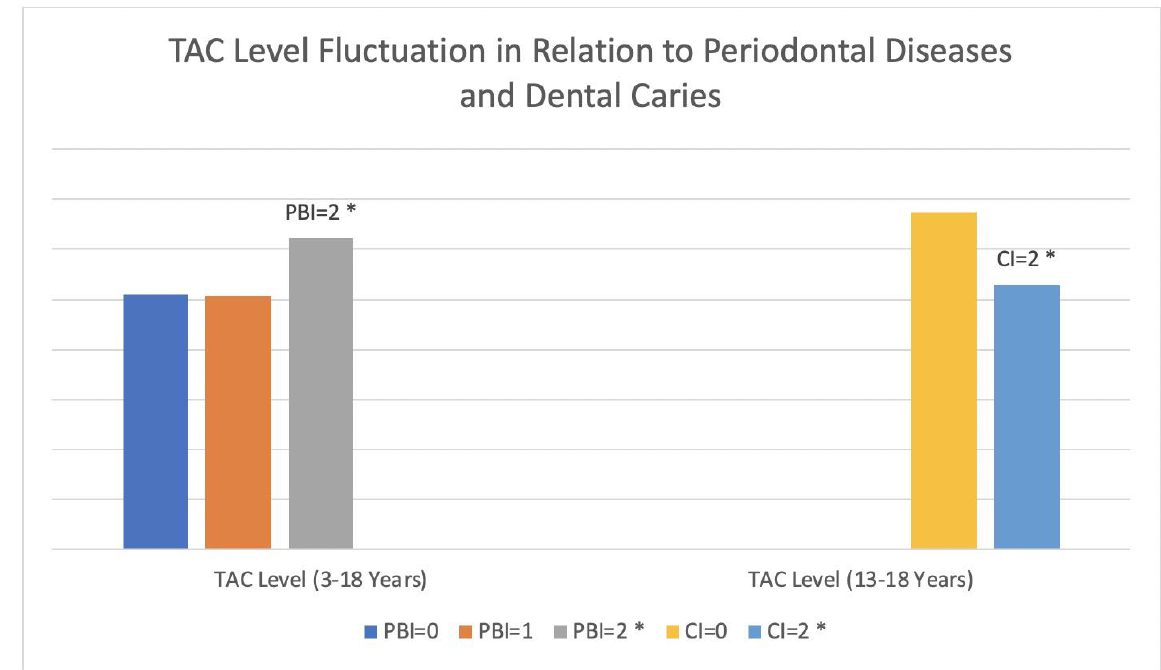
Figure 3. TAC level ( µ mol/L) fluctuation in relation to periodontal diseases and dental caries. * Indicates p -value <